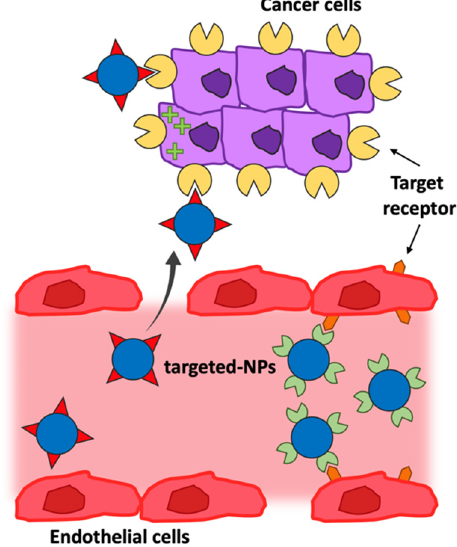
Figure 7. Active targeting. In the active targeting of cancer cells (tumor-associated antigens in yellow) or tumor-endothelium (antigens in orange), nanoparticles (blue) are designed to bind specific biological structures through the molecular recognition (targeting in red or green) of surface-bound ligands.